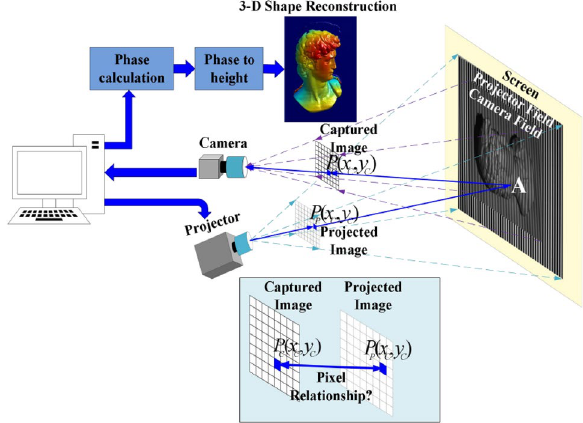
Figure 1. Camera and projector field of